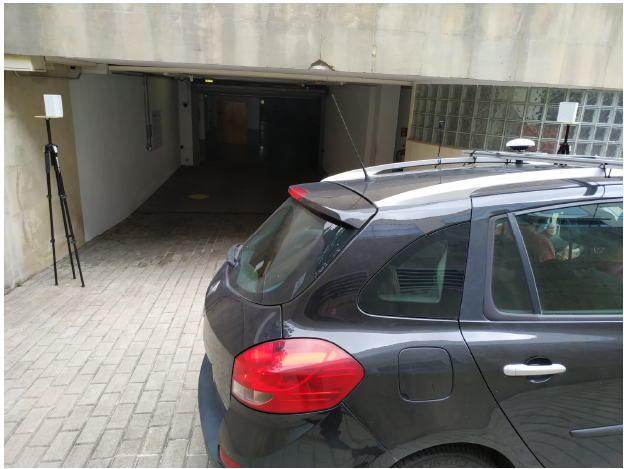
Figure 7. The starting point of the measurement lap at the entrance of the garage and the location